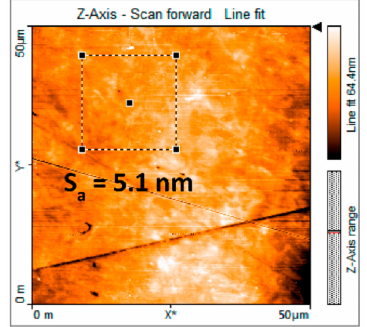
Figure 1. 50 × 50 µ m 2 AFM scan of Eurofer97 showing a surface area roughness of 5.1